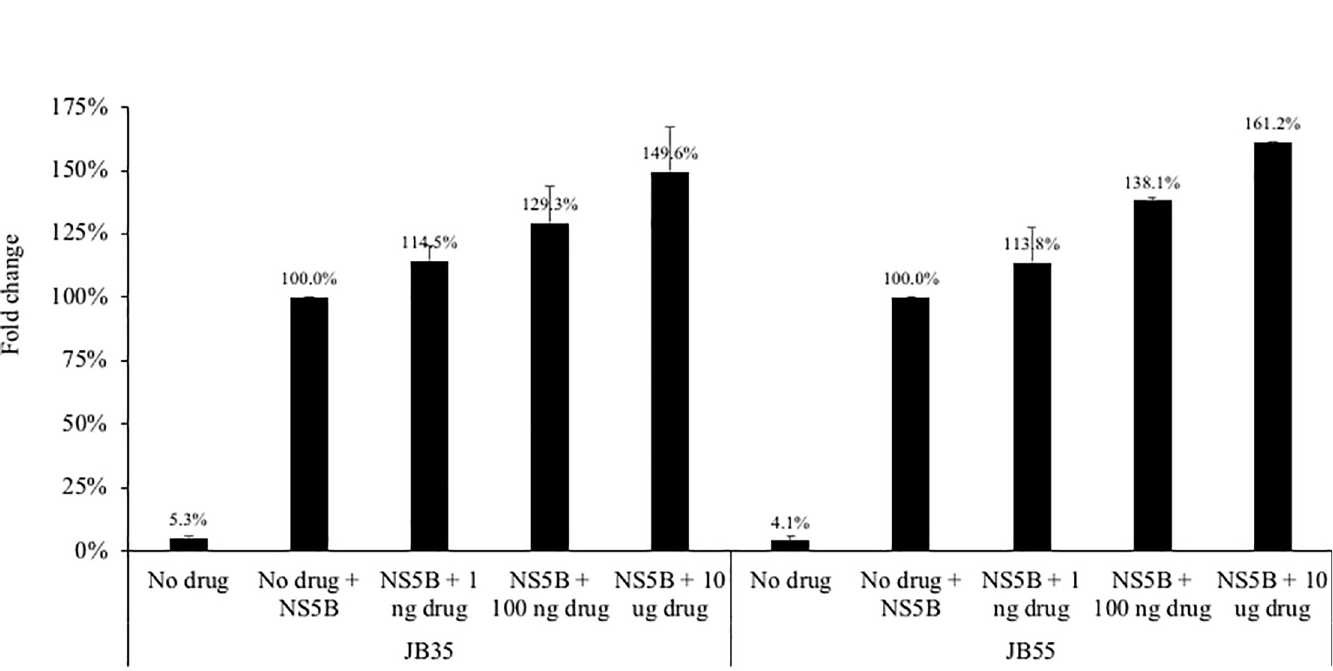
Fig 4. HCV replicative fitness as measured by patient-specific NS5B shuttle vectors expressing luciferase for patients JB35 (left) and JB55 (right). ANOVA for dose effect: p = 0.0002 for JB35 and p = 0.0002 for JB55.